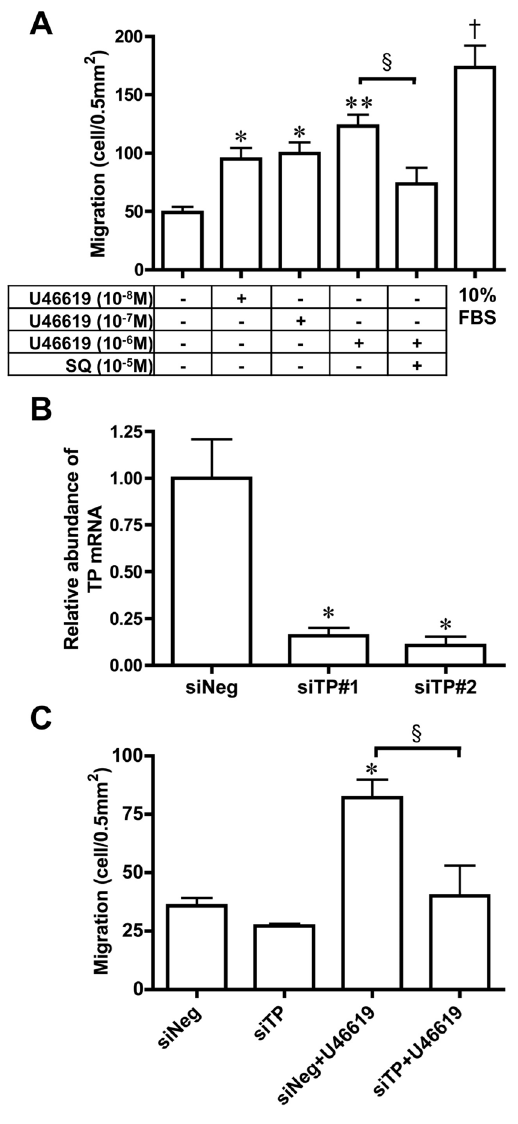
Figure 3. TP stimulation increased DA SMC migration. A) The effect of the U46619 on DA SMCs’ ability to migrate. Cells were incubated with a migration stimulator for 4 hours. Values are expressed as the mean 6 SEM. n=4 to 6.*, **, and { indicate p , 0.05, p , 0.01, and p , 0.001 versus control, respectively; 1 indicates p , 0.05 versus U46619 10 2 6 M. (B) TP mRNA expression in DA SMC treated with siControl, siTP # 1, or siTP # 2. Values are expressed as the mean 6 SEM. n=3. * indicates p , 0.01 versus siNeg. (C) The effect of siRNA-induced TP knockdown on U46619-induced DA SMC migration. Cells were transfected with siControl or siTP # 2 before treatment with U46619. Transfected cells were incubated with/without U46619-containing media for 4 hours. Values are expressed as the mean 6 SEM. n=3. *indicates p , 0.01 versus siNeg; 1 indicates p , 0.01 versus si- Neg + U46619.